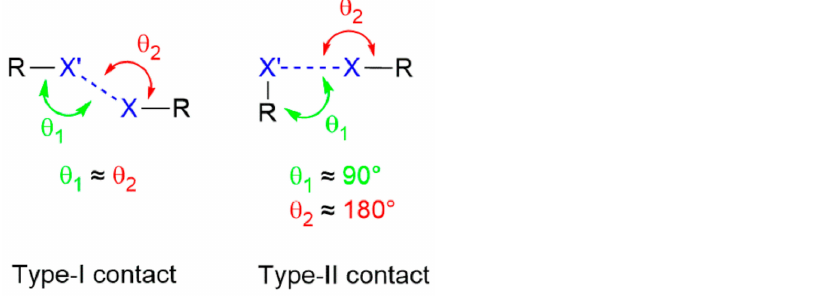
Figure 2. Schematic showing type-I and type-II interactions occurring between